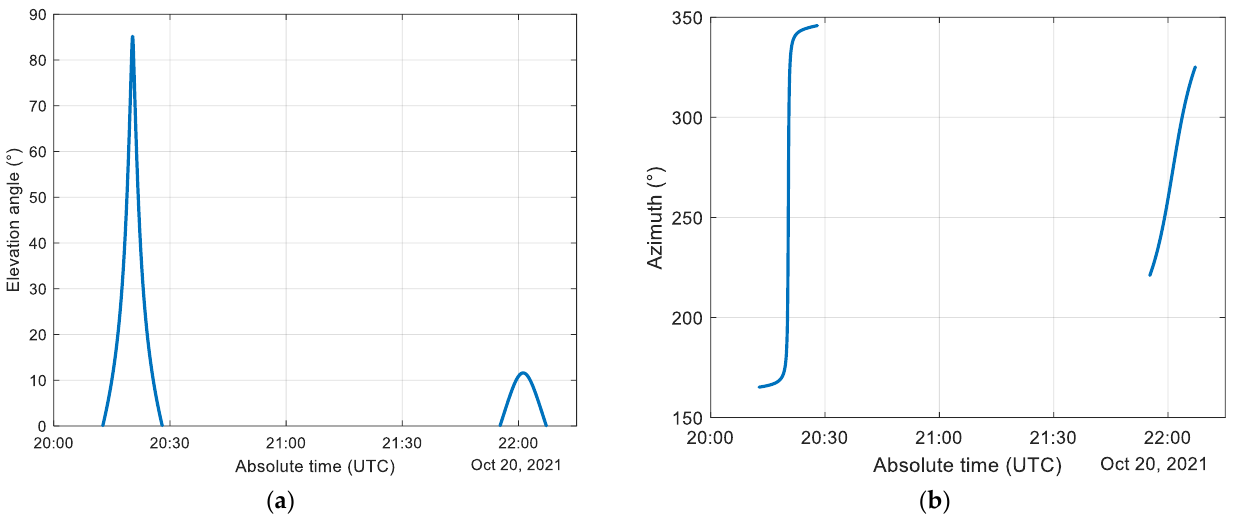
Figure 9. Sample visibility windows: Metop −C satellite seen from Spino d’Adda. ( a ): LEO satellite elevation angle. ( b ): LEO satellite azimuth.